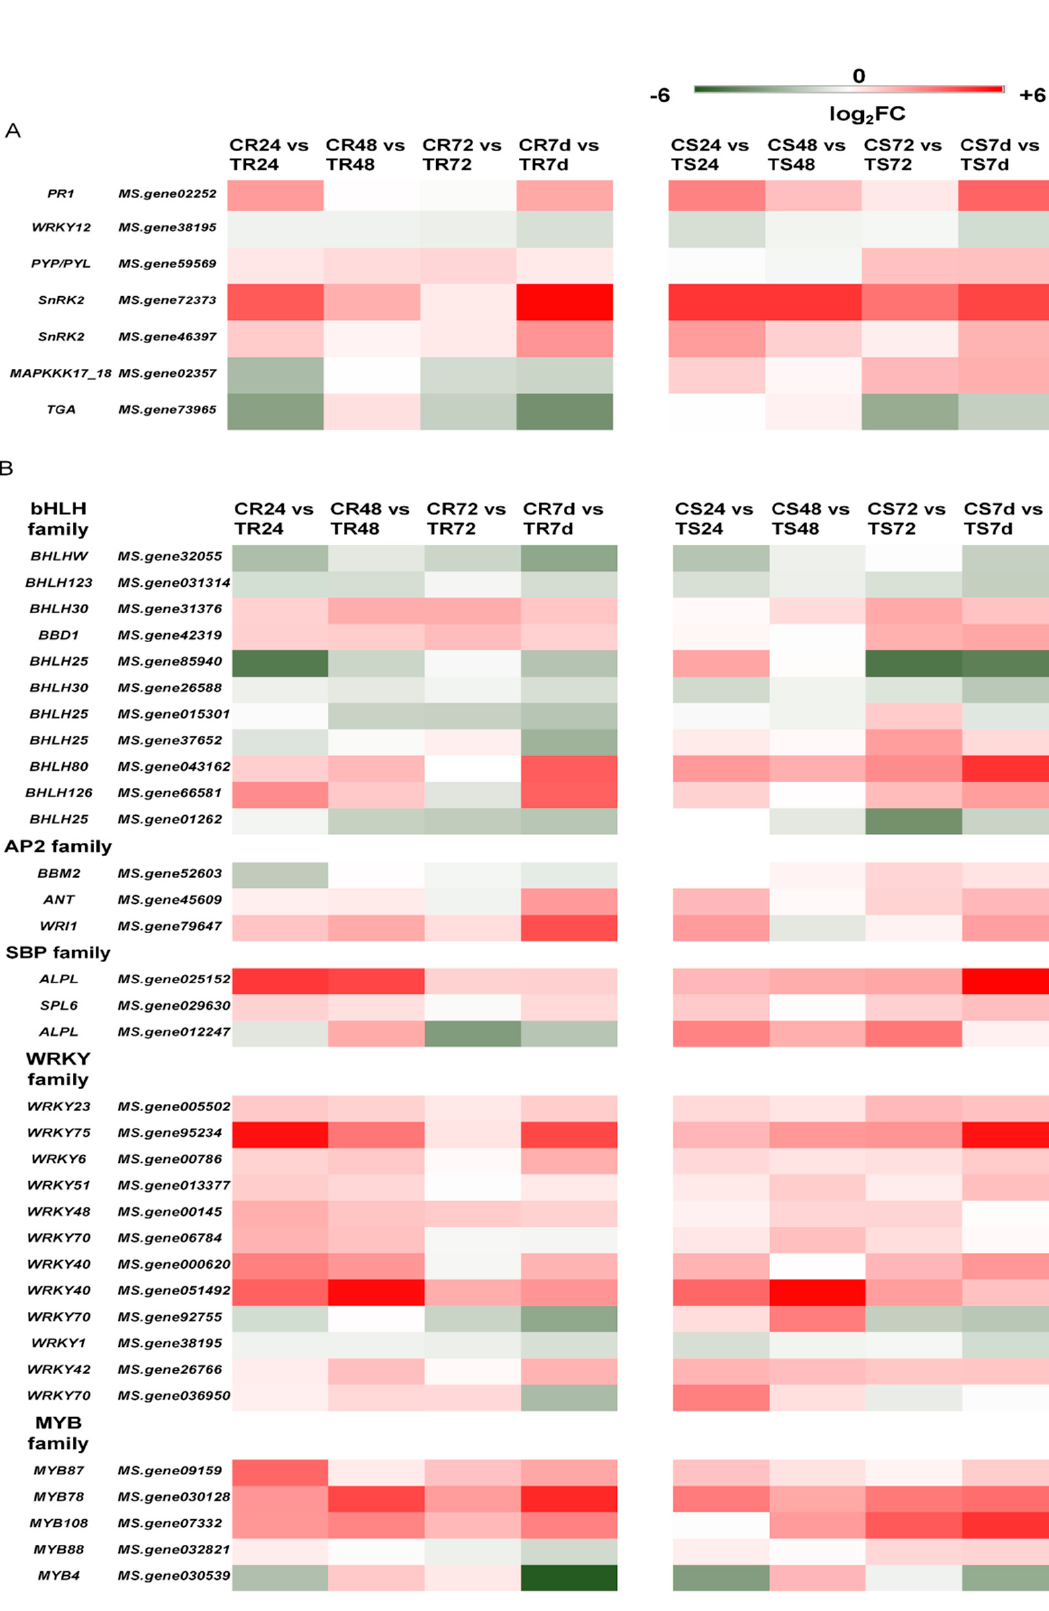
Figure 6. Relative expression of plant–pathogen interaction genes and disease–resistant transcrip- tion factor families in two clonal lines. ( A ) Relative expression of plantpathogeninteractionrelated genes in two clonal lines. ( B ) Relative expression of disease–resistant transcription factor families in the two clonal lines.